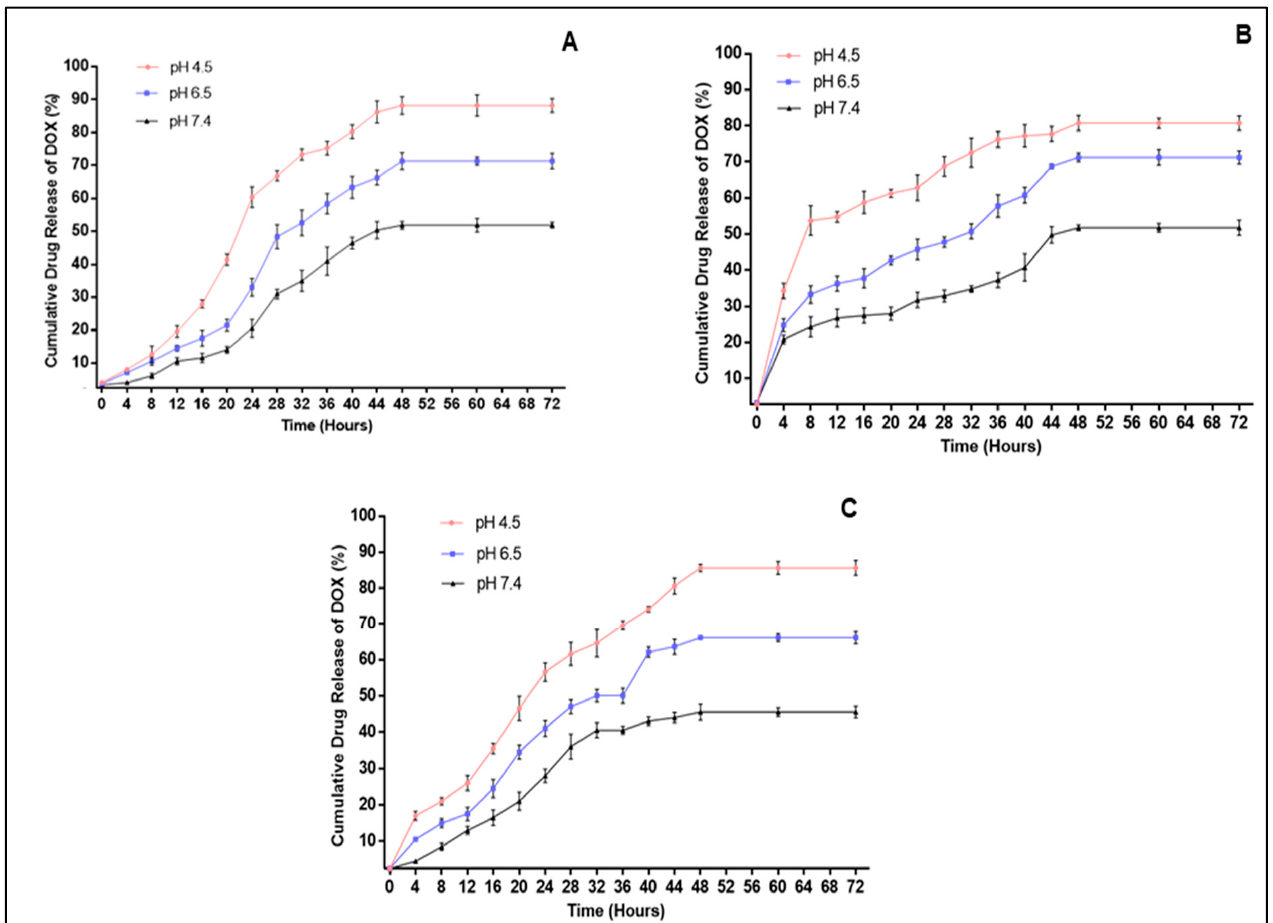
Figure 5. In vitro drug release profile of DOX from ( A ) DOX- CHI-MgFe 2 O 4 , ( B ) DOX-PVA-MgFe 2 O 4 and ( C ) DOX-PEG- MgFe 2 O 4 MNPs at pH 4.5, 6.5 and 7.4.